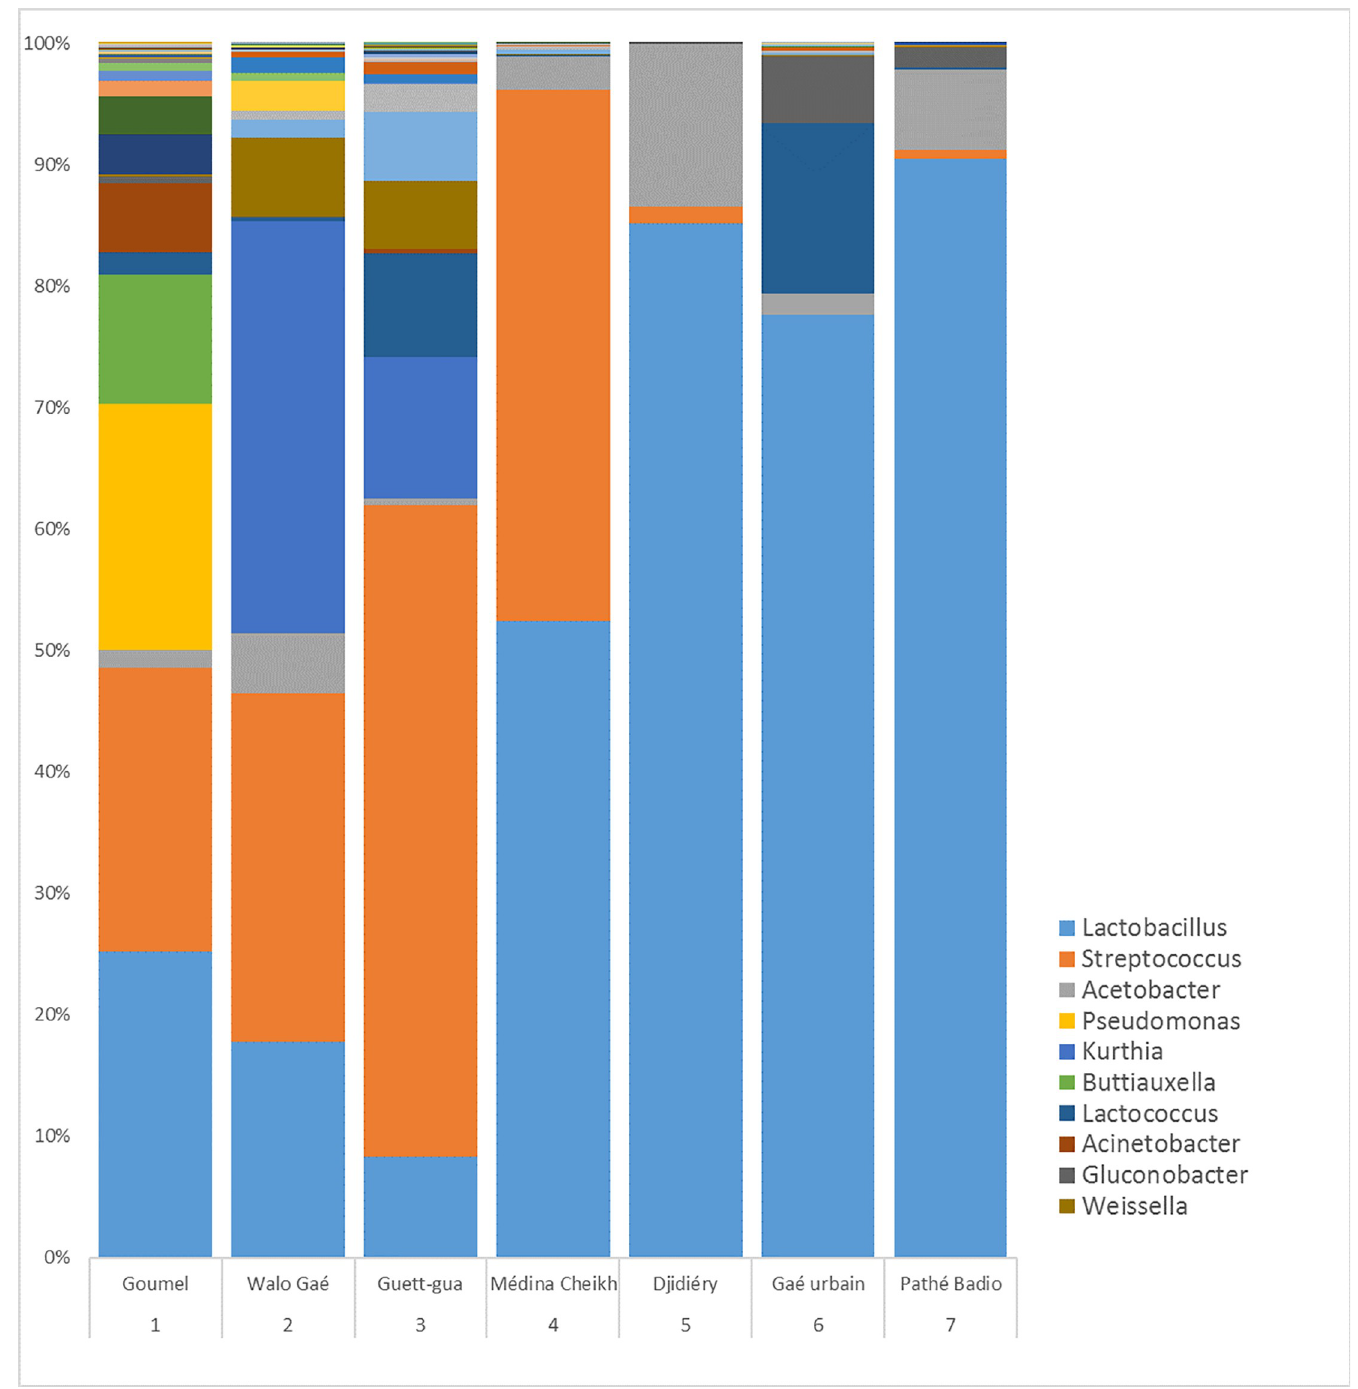
Fig 1. Bacterial composition of biofilm samples of all lahals upon arrival at the laboratory. Different colors indicate different genera and can consist of different species and different OTUs. The ten genera with highest abundance are indicated in the legend. The aim of the figure is to show the diversity found in the microbial communities of lait caille´ in terms of genus and species variation. For specific abundances of species and OTU, please refer to the sequencing data provided with this publication. Lahal numbers are used consistently throughout the experiments. Locations indicate the origin of the lahals.